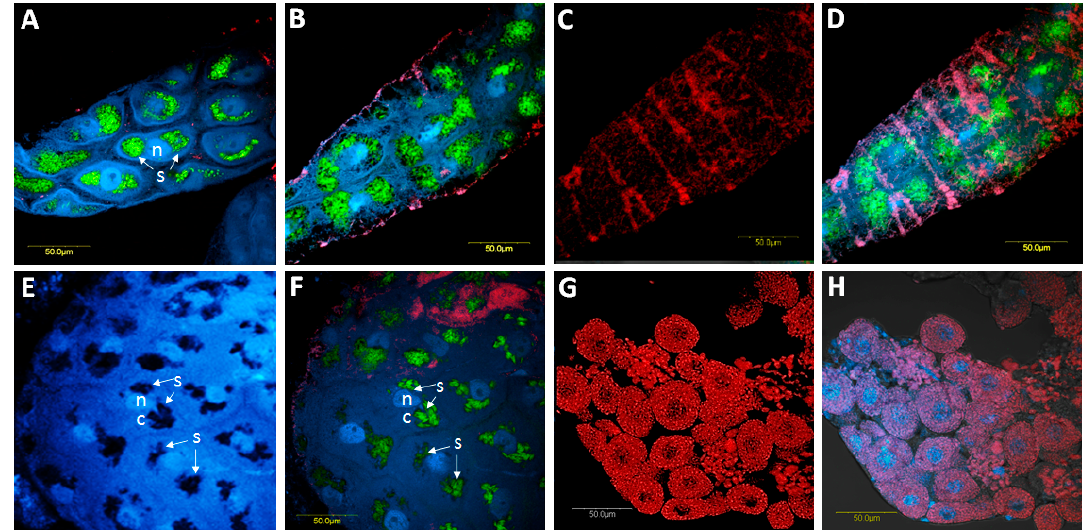
Figure 7. Co-localization of Spiroplasma and CLso in the B. trigonica midgut using FISH. A , B , focal plans showing the localization of Spiroplasma (green) in BT midguts by FISH and DAPI-stained nuclei (blue). In these focal planes, some localization of CLso appears (red). C , the same portion of the midgut in B showing the localization of CLso (red). D , overlay of Spiroplasma , midgut nuclei and CLso under bright field. E-F, other views of Spiroplasma localization (green) and DAPI-stained nuclei (blue). E , Spiroplasma patches around the nuclei without any staining. F , Spiroplasma patches with staining. G , FISH using Carsonella (red) and Spiroplasma probes in bacteriocytes. Spiroplasma was not detected inside bacteriocyte cells. H is the overlay of Carsonella , Spiroplasma and DAPI-stained nuclei in bacteriocytes. n: nucleus; c: cellular cytoplasm. Arrows indicate, s: Spiroplasma .